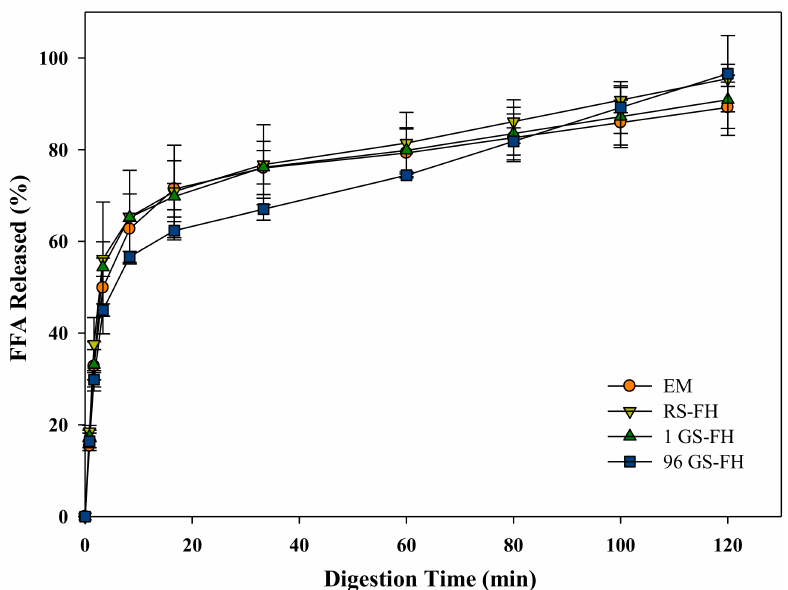
Figure 4. Release profiles of free fatty acid (FFA) released (%) from curcumin-loaded in emulsion (EM), native rice starch-based filled hydrogel (RS-FH), 4- α -glucanotransferase treated (for 1 h) rice starch-based filled hydrogel (1 GS-FH), and 4- α -glucanotransferase treated (for 96 h) rice starch- based filled hydrogel (96 GS-FH). The error bars represent the mean and standard deviations of triplicate